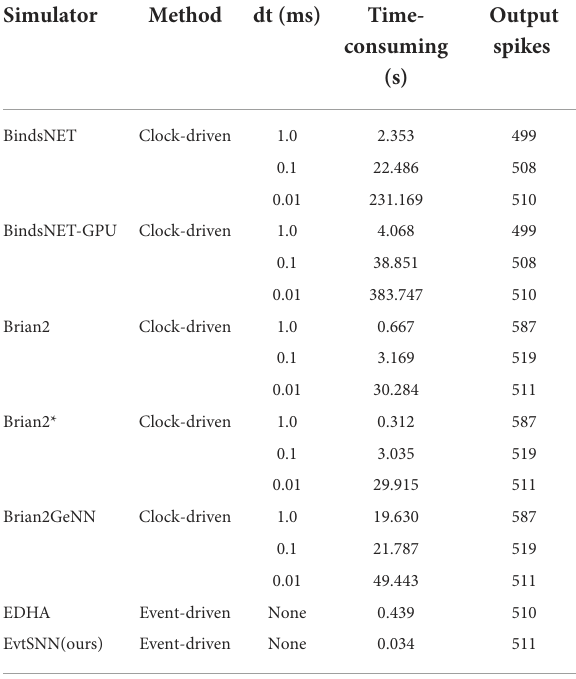
TABLE 2 Performance test results of